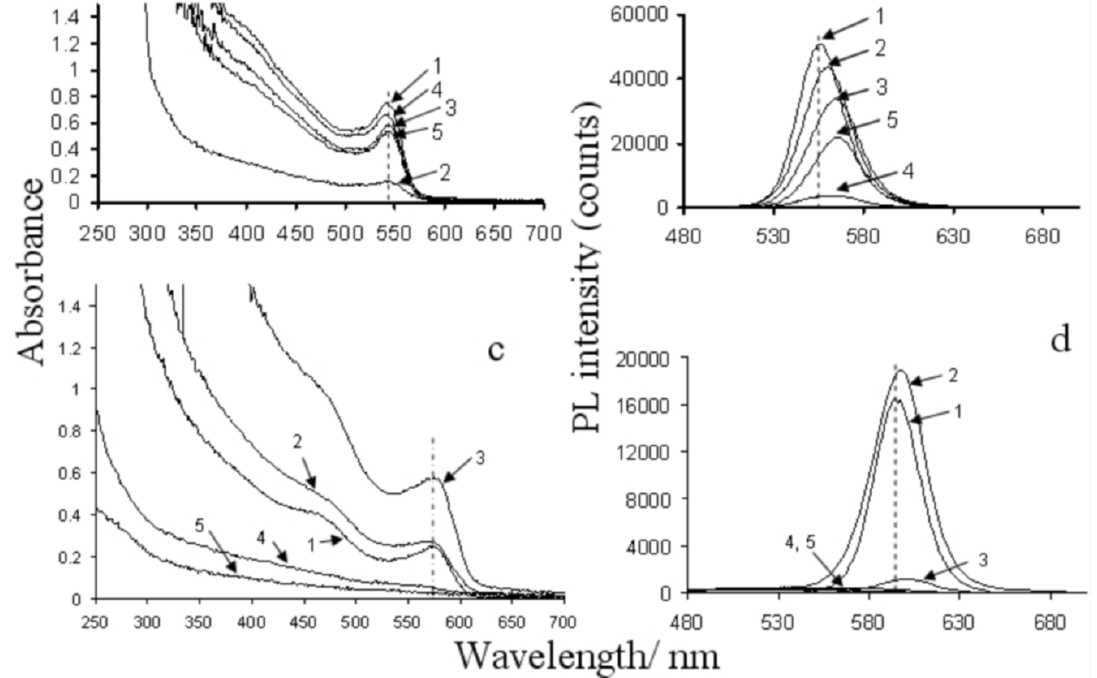
Figure 1. Comparison of CdSe QDs surfactant coating efficiency and coating influence on photoluminescence intensity. Upper (a, b) 2.6 nm CdSe/ TBP/TOPO; below (c, d) 2.9 nm CdSe/TOP/TOPO QDs. UV-Vis (a, c) and PL (b, d) spectra were measured on the same sample. Media: 1, chloroform; 2, TX-100 10%; 3, N-101 10%; 4, CTAB 100 mM; and 5, SDS 100 mM. The original sample 4 (upper) was diluted 1:1 with water to reduce the